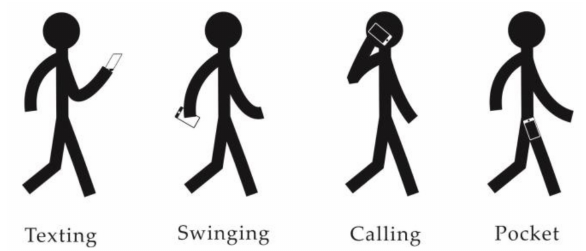
Figure 2. Four basic pose